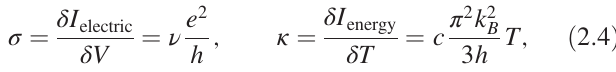
r Þ ; m r Þ(cid:3) of the x ð y ð